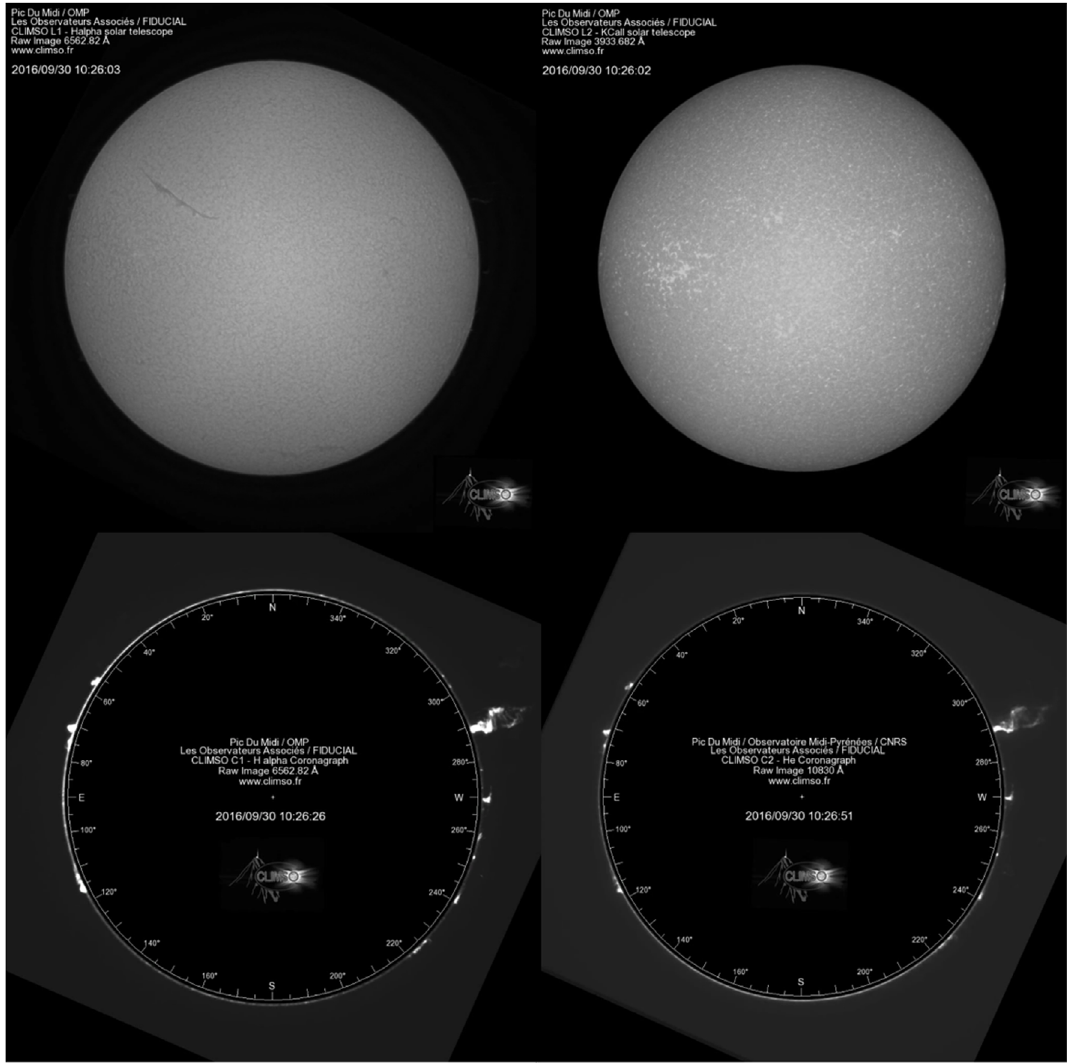
Fig. 3. Images from the four instruments taken on 30 September 2016 around 10:26 UT. The L1 H a refractor is on the top left panel; L2 CaII K refractor on top right; C1 coronagraph in H a at the bottom left; and C2 coronagraph in HeI at the bottom right.